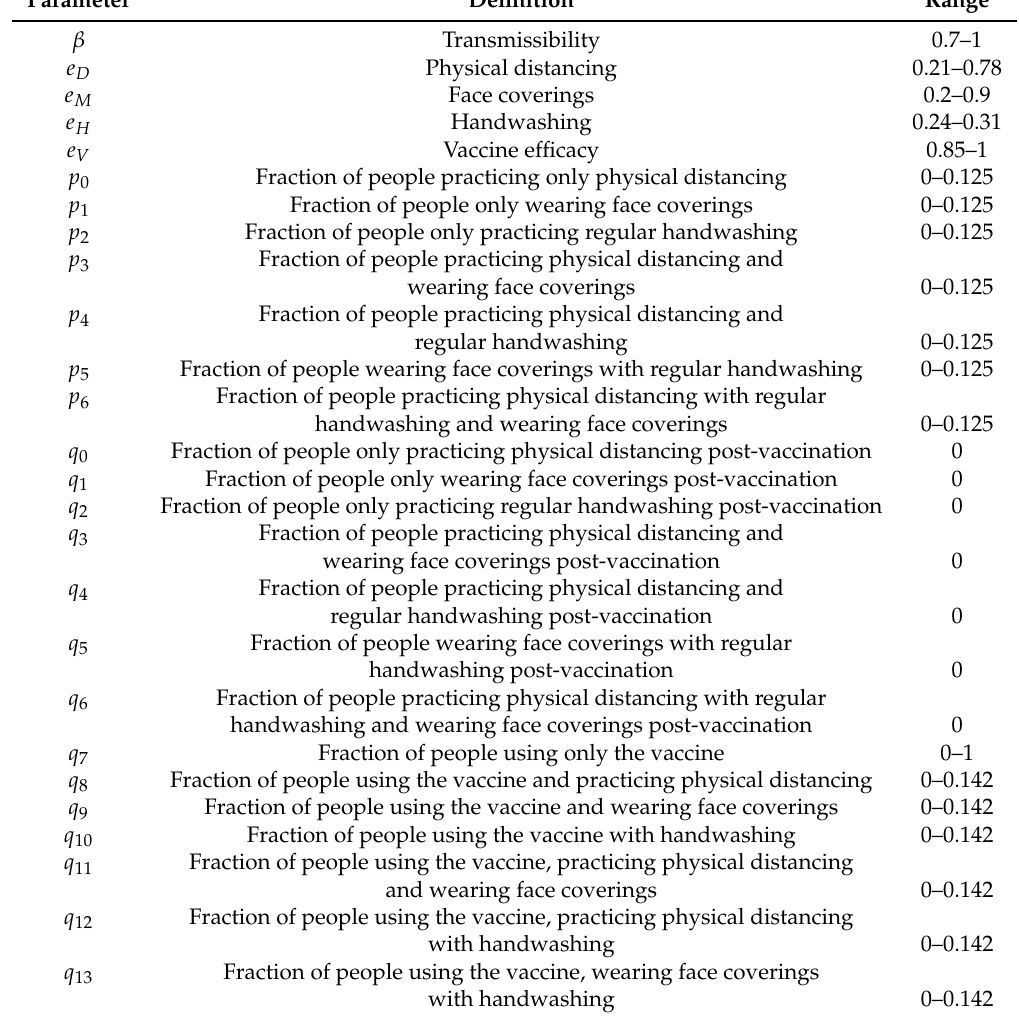
Table 1. Parameter values before and after vaccine introduction. We assumed a uniform use of all available protection protocols (including no protection) before the vaccine. Thus, there are eight possible combinations of protection protocols: p 0 through p 6 and no protection (1 − p 0 − p 1 − p 2 − After the introduction of a vaccine, we considered both the extreme case where vaccination was the only available protection option (0 < q 7 < 1) and the vaccine in combination with other protection options (with upper bound 0.142, including q 7